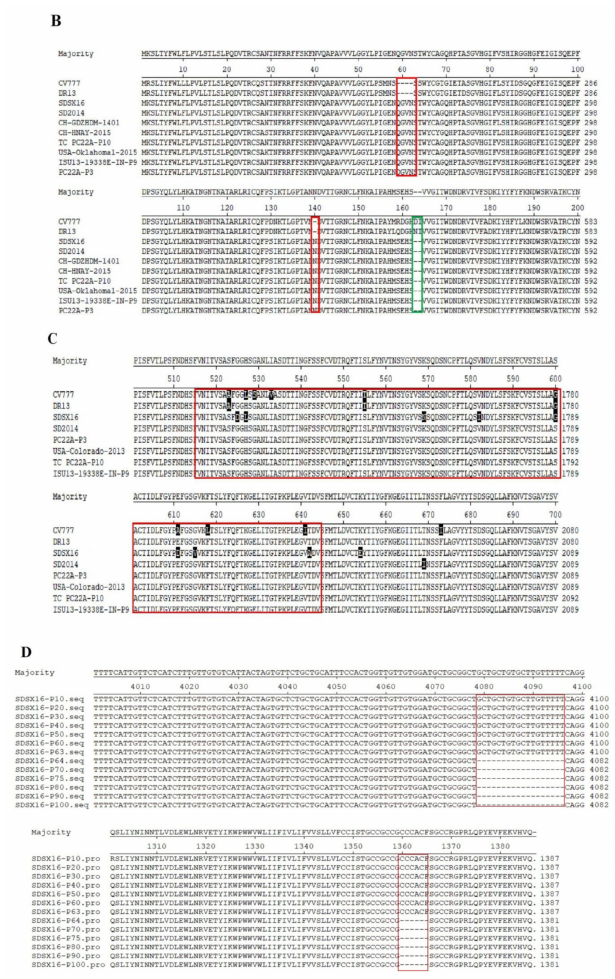
Figure 4. Phylogenetic analysis of S genes of the PEDV SDSX16 ( (cid:78) ). ( A ) Phylogenetic trees generated by the neighbor-joining method with nucleotide sequences of the full-length S gene. Bootstrapping with 1000 replicates was performed. ( B ) PEDV SDSX16 S1 domain and neutralizing epitopes (COE-Black). The red and green boxes represent the insertion and deletion of nucleotides, respectively. ( C ) were analyzed by the MegAlign software of Lasergene 7.1. The red boxes represent the core of epitope (COE). ( D ) Alignments of the S proteins nucleotides and amino acid sequences of SDSX16-P10, -P20, -P30, -P40, -P50, -P60, -P63, -P64, -P70, -P80, -P90, -P100. The red boxes represent the nucleotides